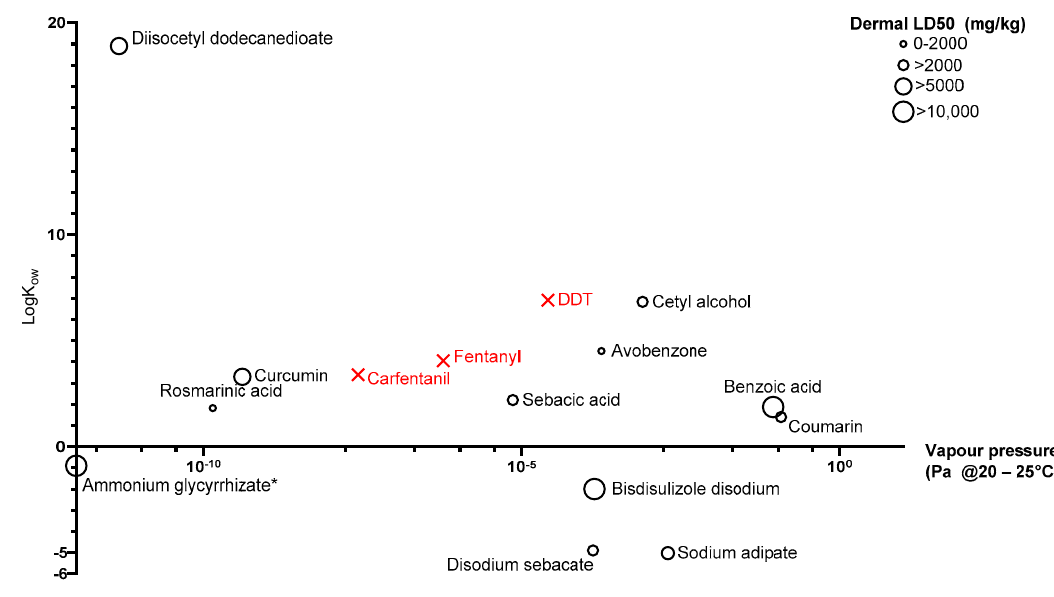
Figure 3. Physicochemical properties of room temperature liquids (top) and solids (bottom) in the green category. Ammo- nium glycyrrhizate (*) has 0 vapour pressure despite 0 being undefined on a logarithmic scale. In addition to logK ow and vapour pressure, the water solubility and molecular weights of solid chemicals are represented in Figure 4.